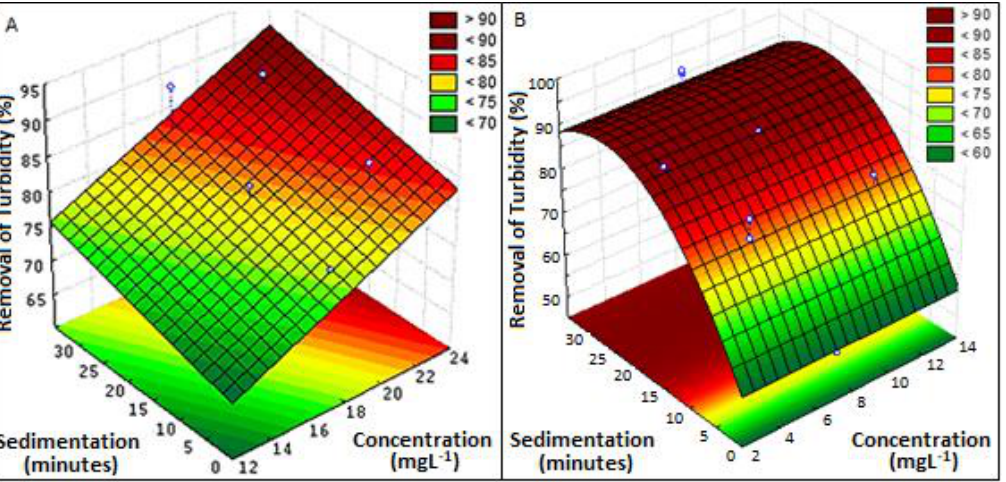
Figure 5. Turbidity treatment surface graphs using magnetite associated with ( A ) tannin and ( B ) Moringa oleifera